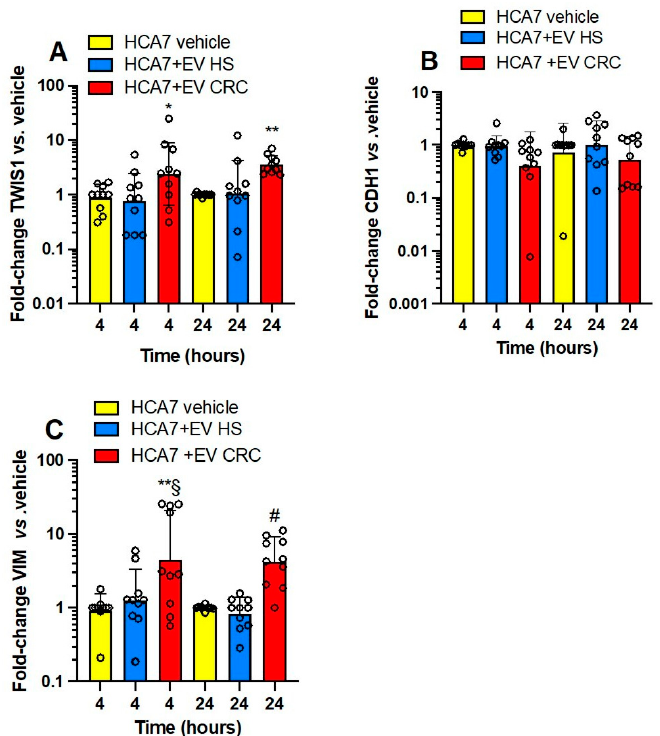
Figure 3. Effects of platelet-derived mEVs on the expression of gene markers of EMT in cocultures with the human colonic adenocarcinoma cell line HCA7. Cancer cells (0.5 × 10 6 ) were incubated for 4 or 24 h with CRC or HS EVs (100 µ g), and gene expression of TWIST1 ( A ), CDH1 (protein name E-cadherin) ( B ), and VIM (protein name vimentin) ( C ) was evaluated by qPCR and normalized to those of GAPDH and reported as fold-change vs. the gene expression detected in the cocultures of mEVs from HS with the cancer cells. The values were not normally distributed and were transformed to logarithms, and all values are shown as scatter dot plots with mean + SD, n = 10, and analyzed by one-way ANOVA followed by Tukey’s multiple comparisons test. ( A ) TWIST1 , 4 h, * p < 0.05 vs. EV HS, 24 h, ** p < 0.01 vs. vehicle and EV HS; ( C ) VIM , 4 h ** p < 0.01 vs. vehicle, § p < 0.05 vs. EV HS, 24 h, # p < 0.01 vs. vehicle and EV HS.